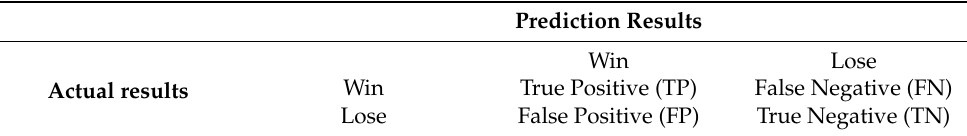
Table 5. Binary Confusion Matrix